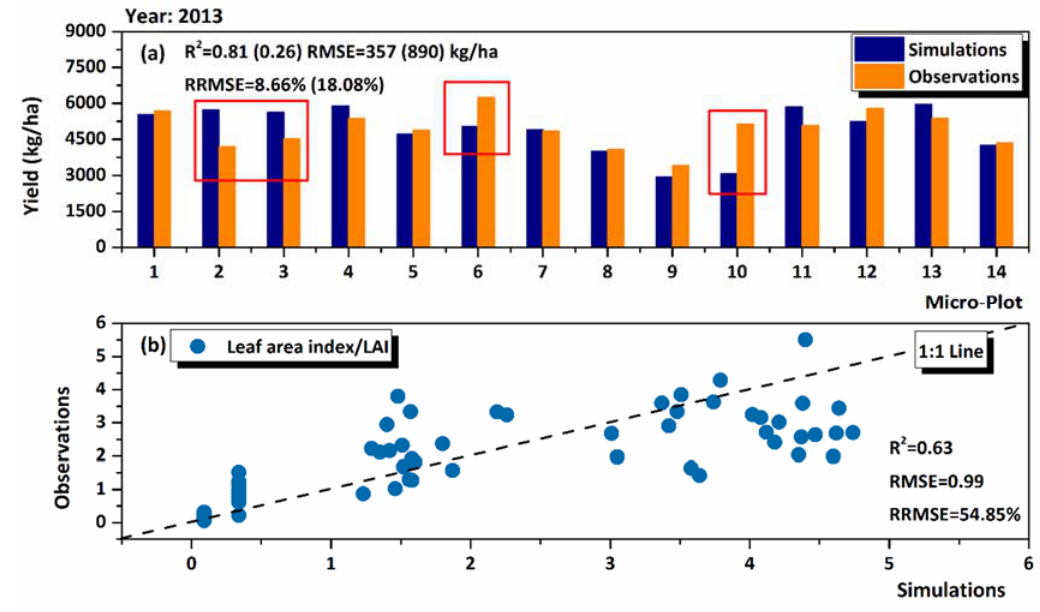
Figure 7. Evaluation of Equations (7)–(9) relative to the observed yield ( a ) and leaf area index (LAI, b ) in 2013. Red squares indicate micro-plots with large differences between simulated and observed yield. R 2 , RMSE, and RRMSE in parentheses are statistical indices ignoring the four micro-plots in the red squares.